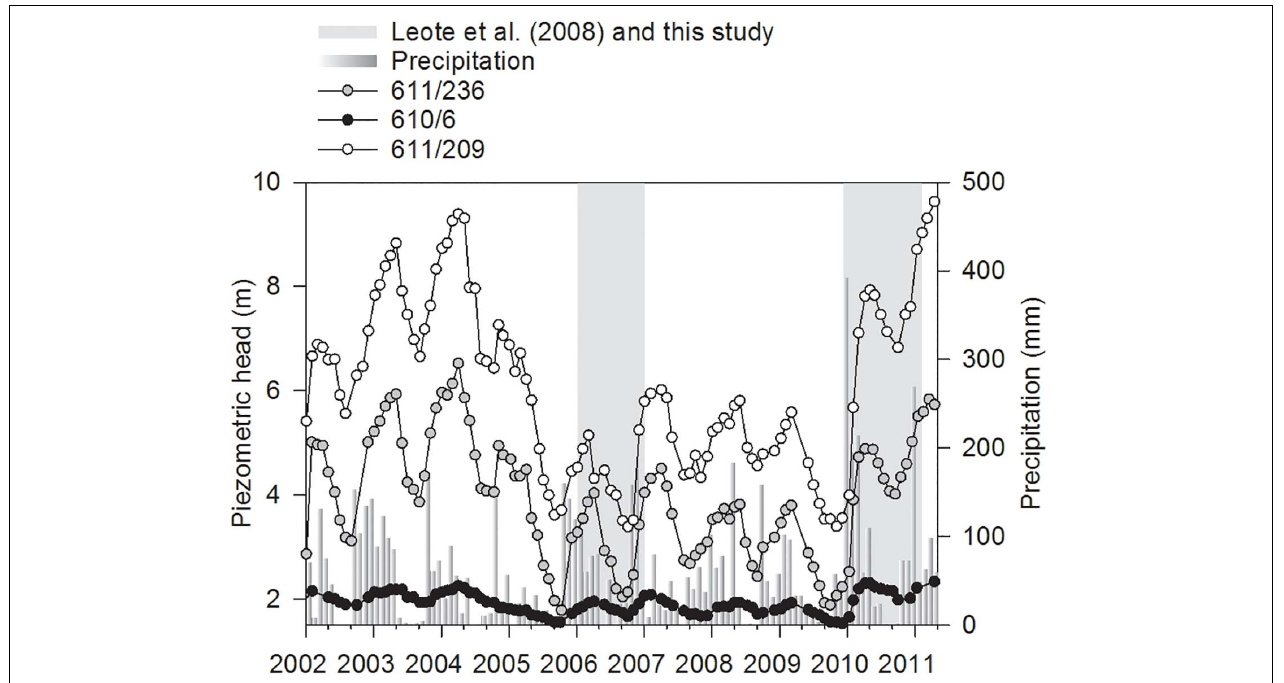
FIGURE 11 | Monthly precipitation as recorded in the meteorological station placed in the airport of Faro (37.02 ◦ N, 7.97 ◦ W) and piezometric head recorded in the 610/6 (37.02 ◦ N, 7.97 ◦ W), 611/236 (37.03 ◦ N, 7.94 ◦ W), and 611/209 (37.05 ◦ N, 7.95 ◦ W) monitoring wells of the Sistema Nacional de Informação de Recursos Hídricos (SNIRH; Portugal; https://snirh.apambiente.pt) from January 2002 until March 2011. Gray areas denote the temporal coverage of surveys presented in Leote et al. (2008) and in this